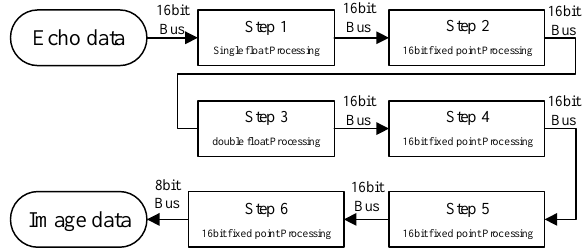
11 of 20 Figure 9. Bit-wise 16 bit vs. single-precision processing results. To obtain the optimal processing results, the processing accuracy needs to be com- bined with fixed-point and floating-point starting from the simulation results and com- bining the Xilinx XC7VX690T FPGA chip resources [32]. The data input is buffered into the DDR by a 16-bit fixed-point, and the range compression by floating-point processing.